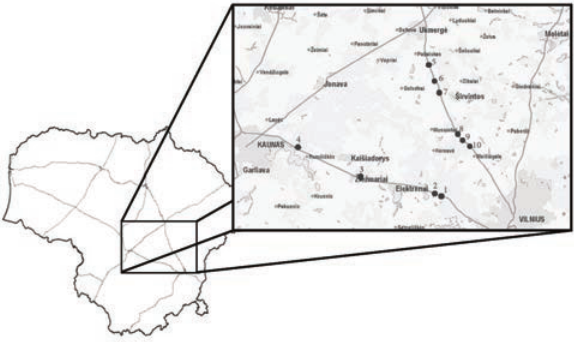
Fig. 1. Placement of investigation sites. Site